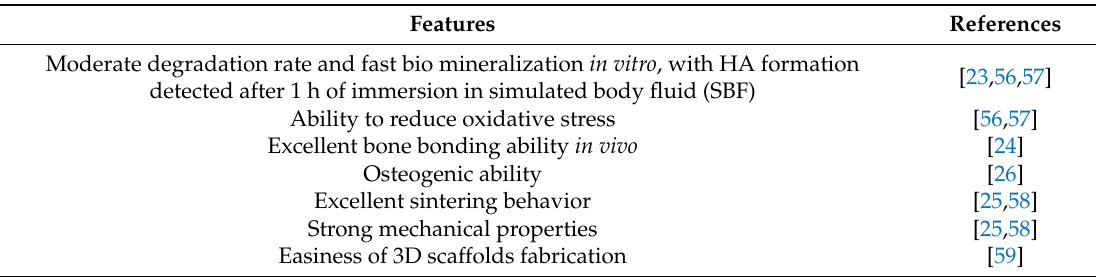
Table 1. Features of the alkali-free FastOs ®